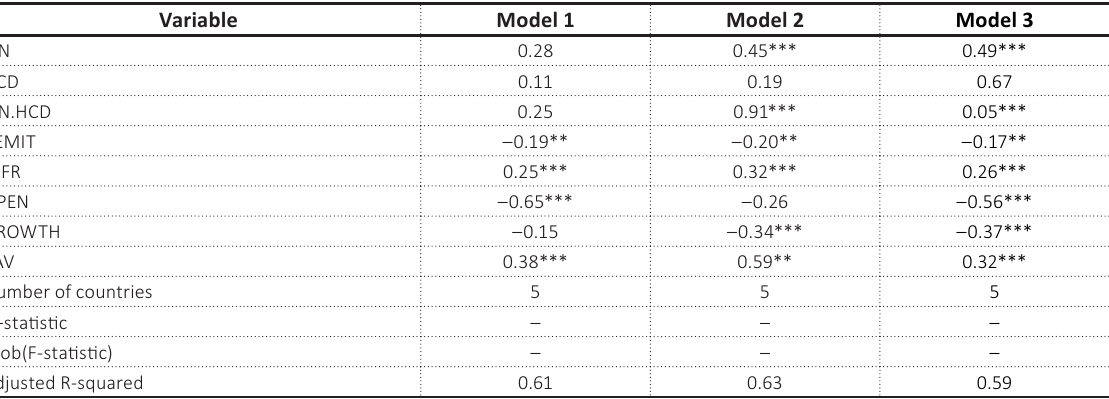
Table 8. Financial sector development and FDI inflows – Pooled ordinary least